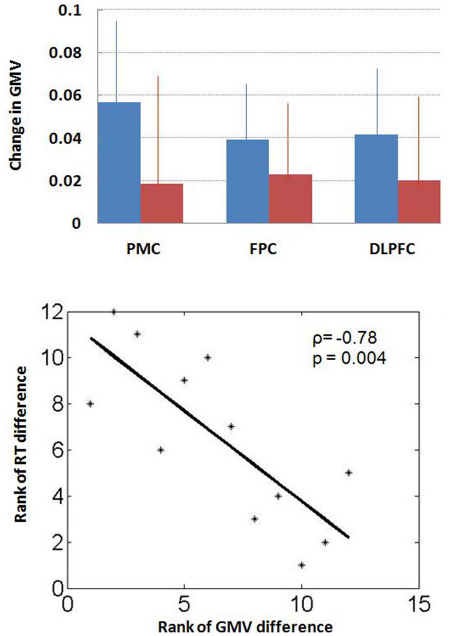
Figure 2. Changes (mean 6 s.d.) in Gray matter volume (GMV) for the three regions of interest: primary motor cortex (PMC), frontopolar cortex (FPC), and dorsolateral prefrontal cortex (DLPFC), for the ADT (blue) and control (red) group (upper panel). A decrease in the GMV of the PMC correlated with prolonged reaction time to target detection during the zero-back condition in the ADT group (lower panel). Because of the small sample size, we used a Spearman regression for correlation (p , 0.0042, rho= 2 0.7832). The result of Pearson regression was also significant: p , 0.0049.